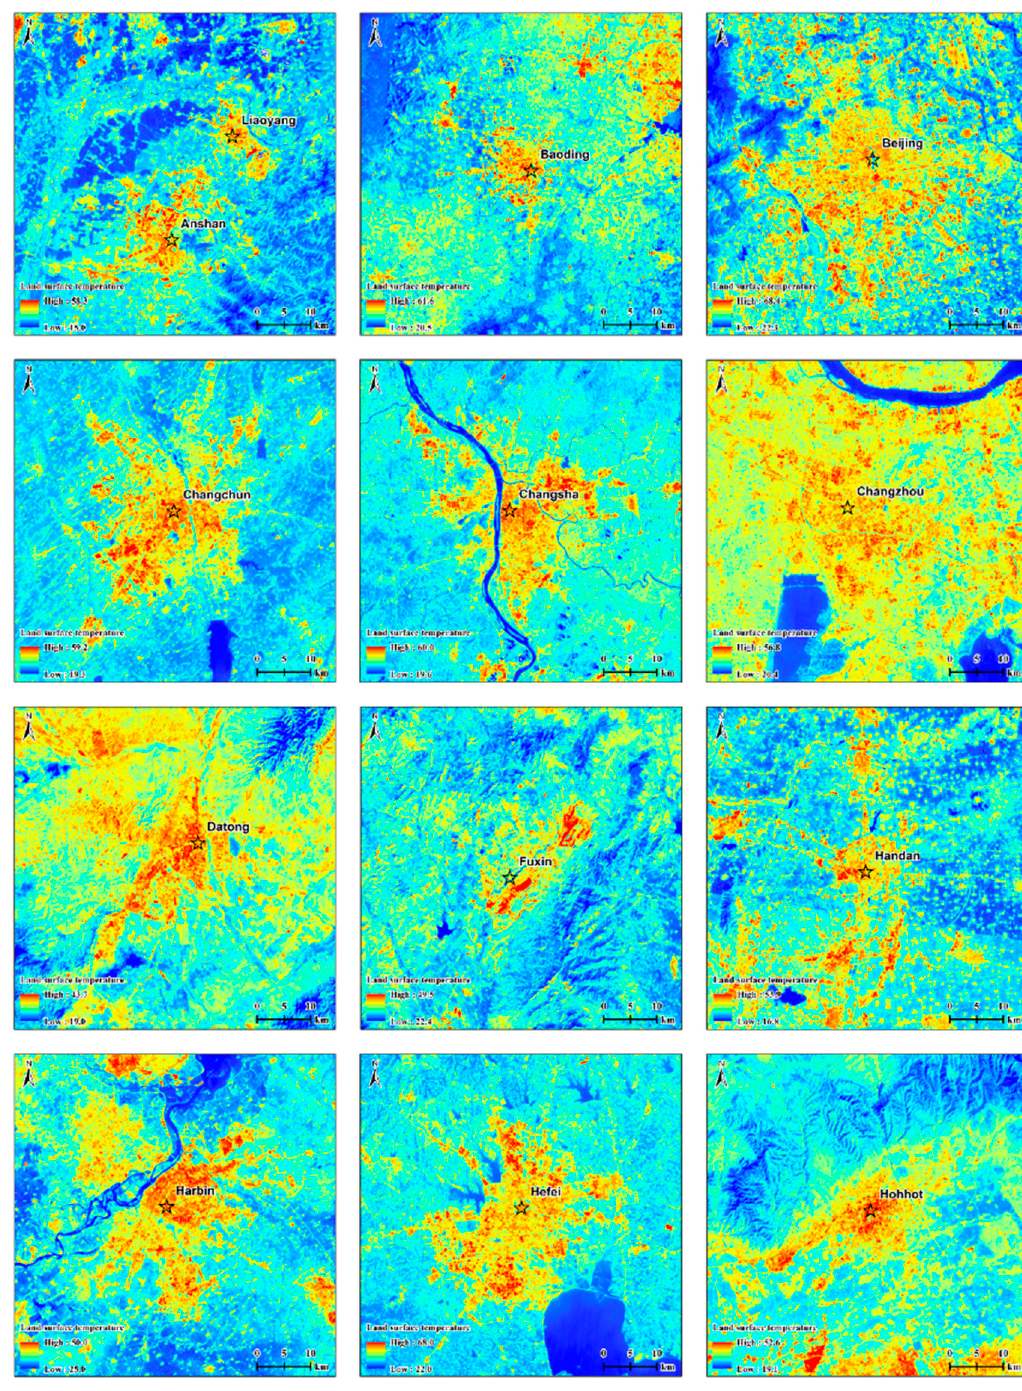
Figure A2. Map of the land surface temperature (LST) data for the 32 Chinese cities. Figure A2.